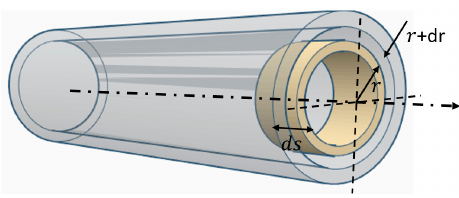
Figure 1. Schematic view of an axisymmetric shell element of fluid inside a pipe.